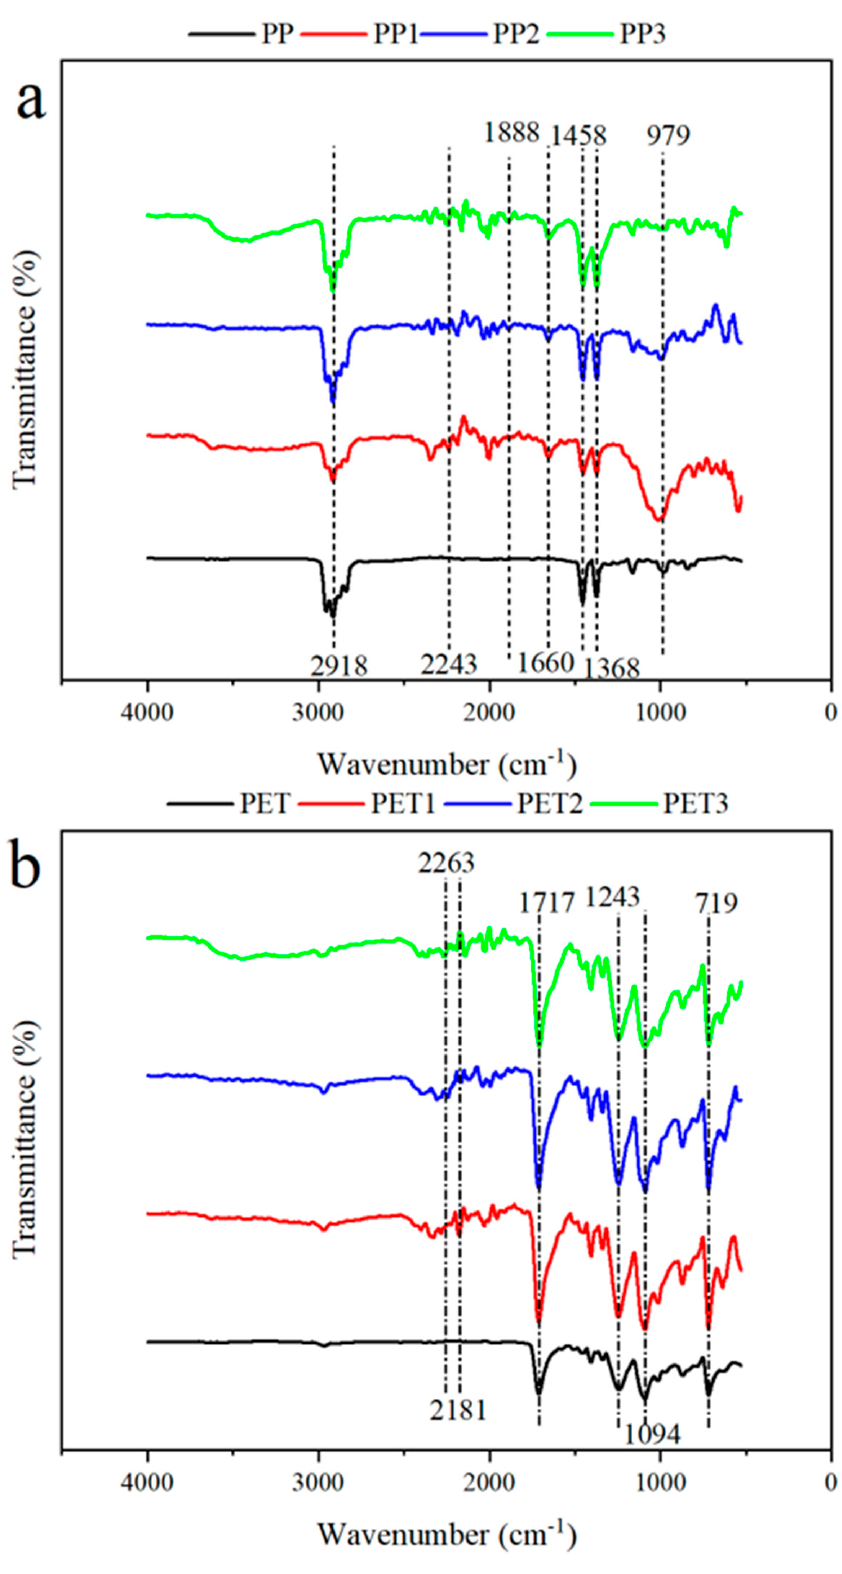
Figure 3. FT-IR of virgin and biofilm-covered plastic debris before adsorption, (a) for virgin PP and biofilm-covered PP; (b) for virgin PET and biofilm-covered PET. PP and PET: virgin plastic; PP1 and PET1: biofilm-covered plastic in Xuanwu Lake; PP2 and PET2: biofilm-covered plastic in Donghu Lake; PP3 and PET3: biofilm-covered plastic in the Qinhuai River.